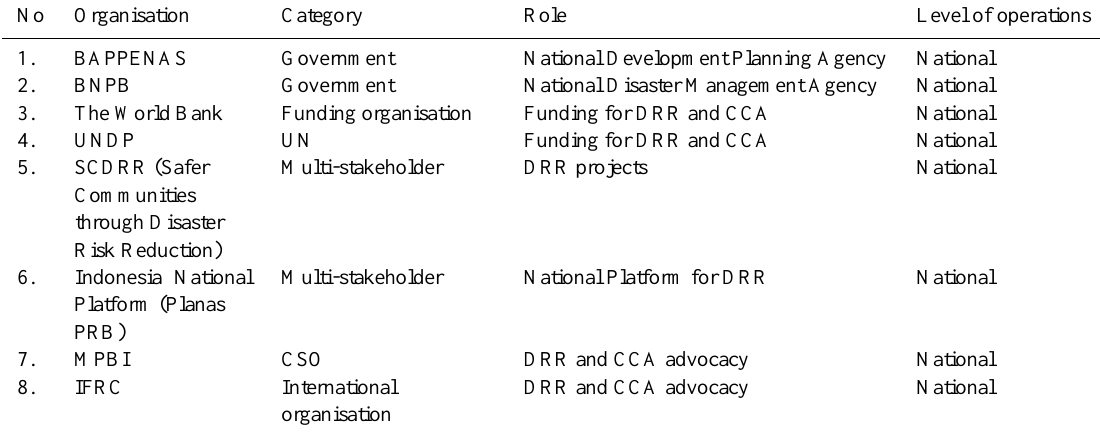
Table 1. List of organisations included in the interviews on MSPs in